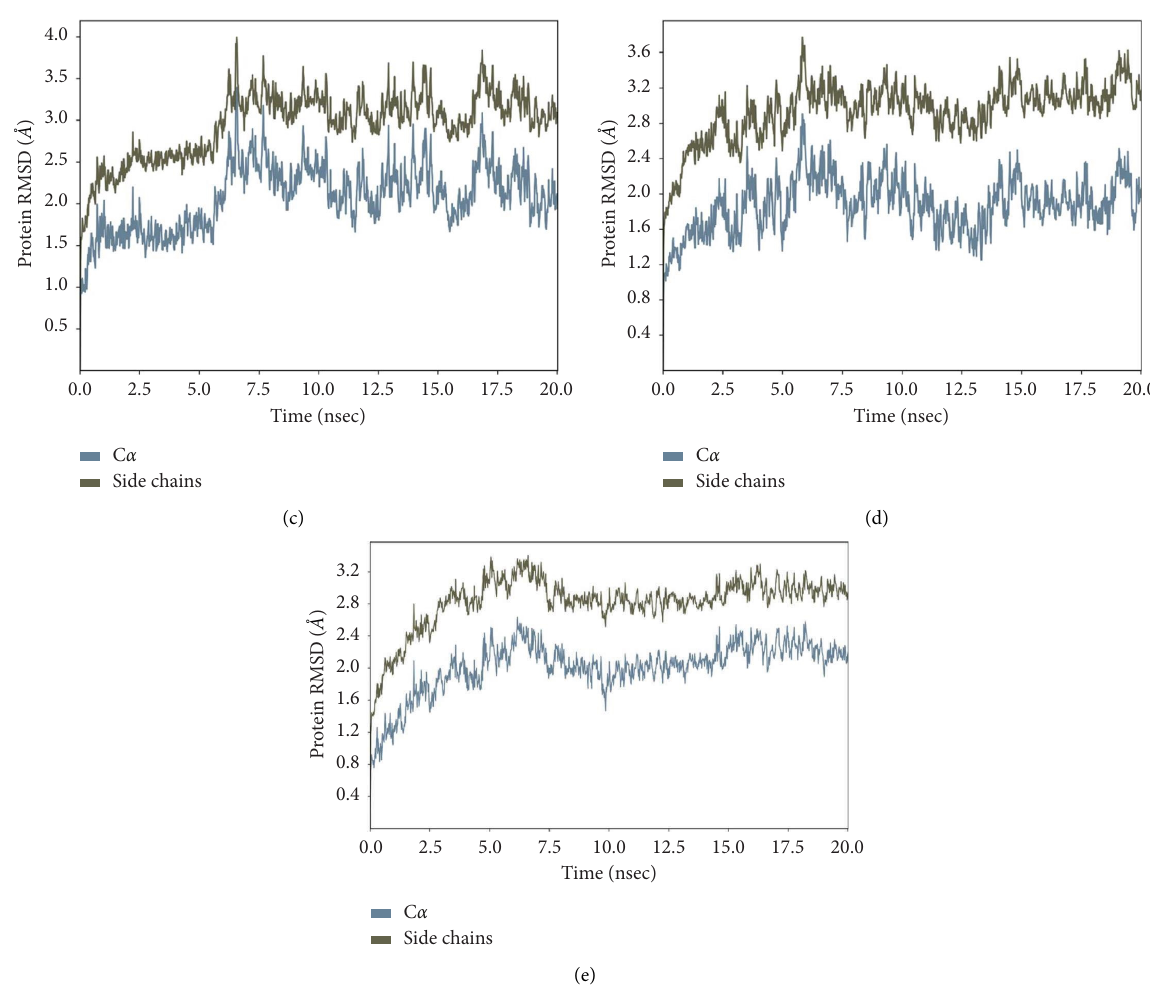
Figure 4: RMSD plots for each ligand: (a) quercetin; (b) procyanidin; (c) oleic acid; (d) methyl linoleic acid; (e)